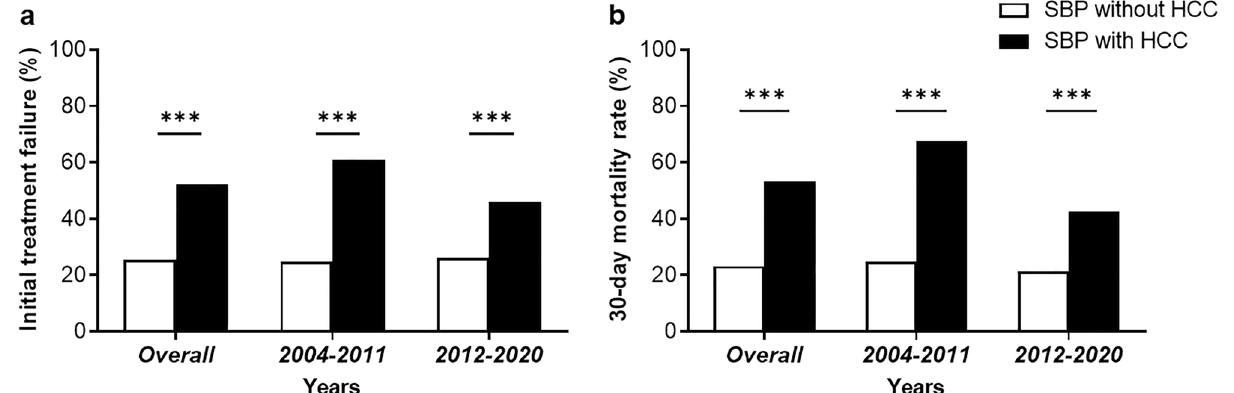
Figure 1. Initial treatment failure ( a ) and 30-day morality rate ( b ) in spontaneous bacterial peritonitis (SBP) patients with and without hepatocellular carcinoma